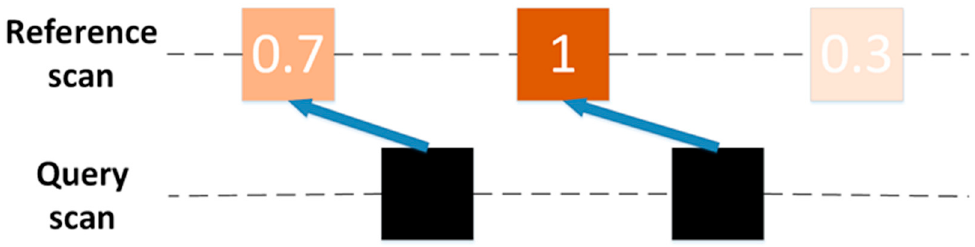
Figure 9. Scanning point cloud of two adjacent frames. In the reference scan, the color and number of the square represent the target with different occupation probabilities. In the end, the only correct matching relationship is obtained, as shown by the blue arrow.